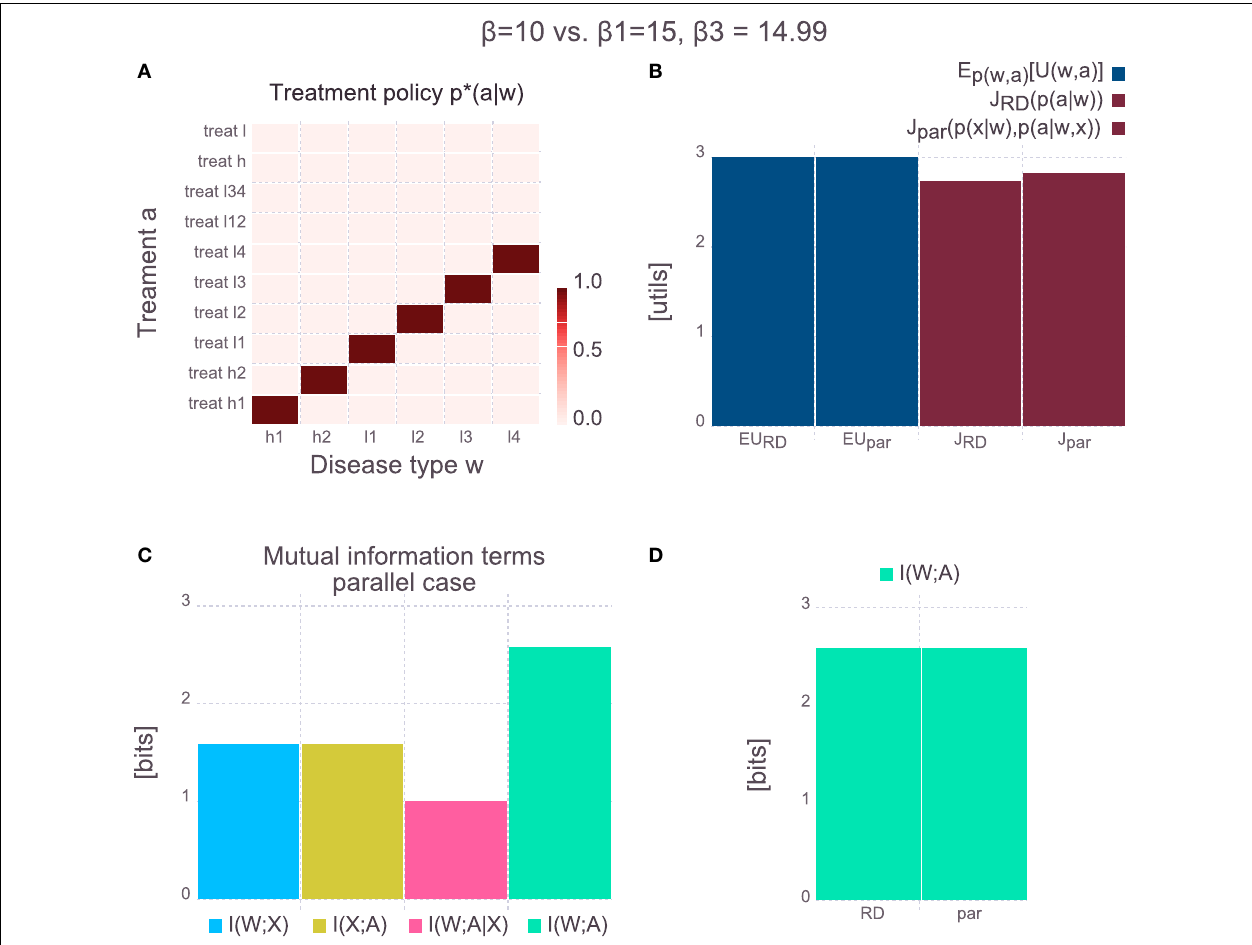
FIGURE 11 | Bounded-optimal parallel hierarchy (denoted by “par”) versus one-step (rate-distortion) case (denoted by “RD”) . (A) Overall-behavior p *( a | w ) =(cid:6) x p *( x | w ) p *( a | w , x ). The overall-behavior is identical for the one-step case and the parallel hierarchical solution. Due to the low price of information processing each w is deterministically mapped to the best a . (B) Comparison of performance of one-step (“RD”) and parallel case (“par”). Both solutions achieve the same expected utility but the hierarchical solution has a better trade-off between expected utility and information processing cost (because the price of information processing is lower in the hierarchical case 1 (cid:12) , 1 (cid:12) compared to 1 (cid:12) in the one-step case) since in the hierarchical case the cheap but capacity-limited processing 1 3 elements can be used – see main text). J RD ( p ( a | w )) corresponds to equation (7) and J par ( p ( x | w ), p( a | w , x )) corresponds to equation (25). (C) Mutual information terms of the parallel case I ( W ; X ), I ( X ; A ), I ( W ; A | X ), and I ( W ; A ) (from left to right). The individual processing channels in the hierarchical case are all within the capacity limit of 1.58bits, but the overall processed information I ( W ; A ) is (cid:25) 2.6bits. (D) Comparison of “effective” information I ( W ; A ) processed in the parallel case (denoted by “par”) and the information processed in the one-step (rate-distortion) case (denoted by “RD”). I ( W ; A ) is identical for the one-step and the hierarchical case, but in the parallel case it was computed in a distributed fashion, where each computational step (or channel) has a rate lower than I ( A ; W ) [see (C) ]. The figure can be reproduced with the Supplementary Jupyter Notebook